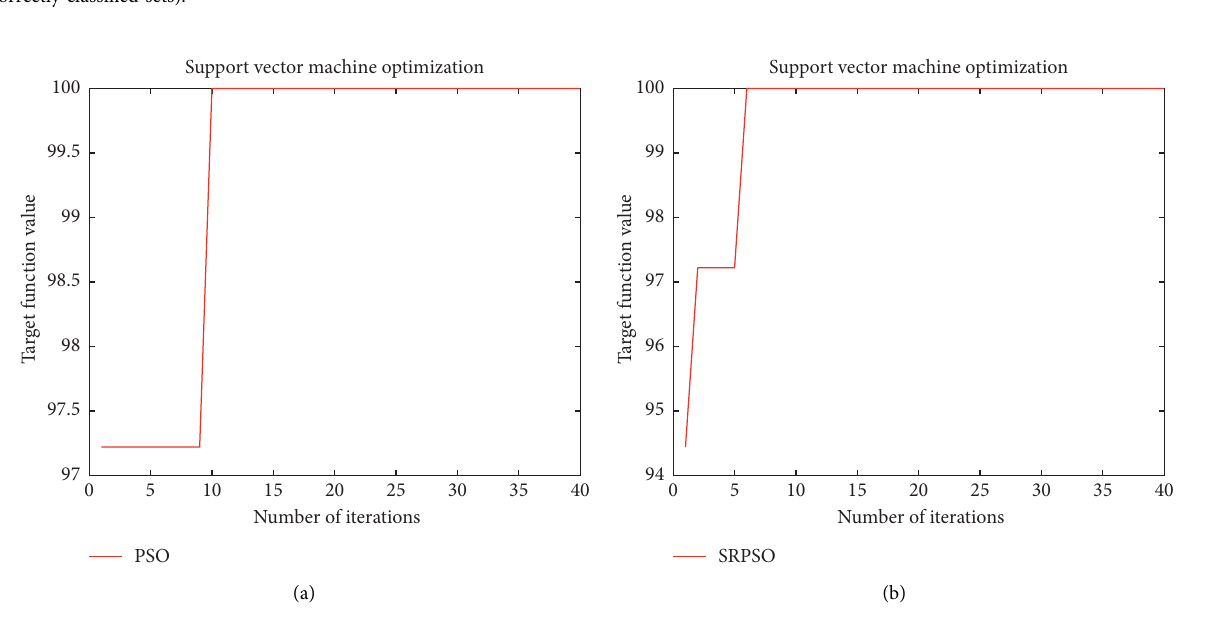
Figure 7: (a) PSO optimization training for multikernel single feature LSSVM. (b) SRPSO optimization training for multikernel single feature